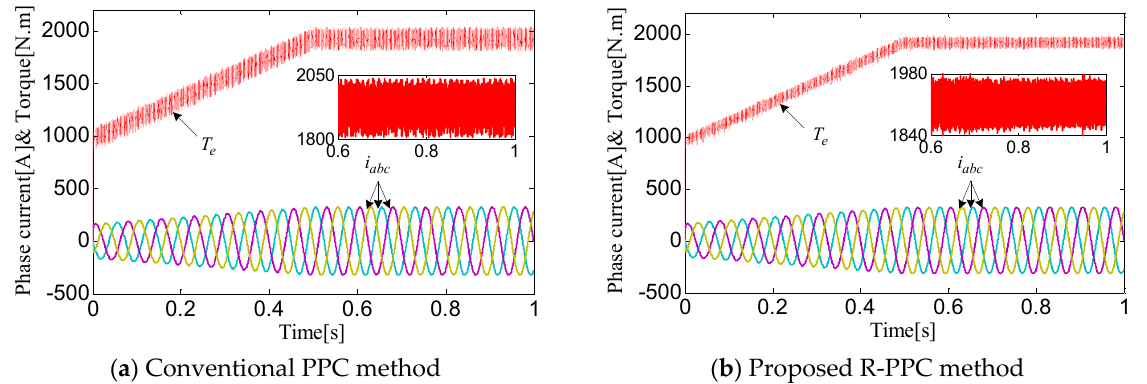
Figure 6. Simulation results of the phase current and torque under the charge state. ( a ) Conventional PPC method; ( b ) Proposed R-PPC method.